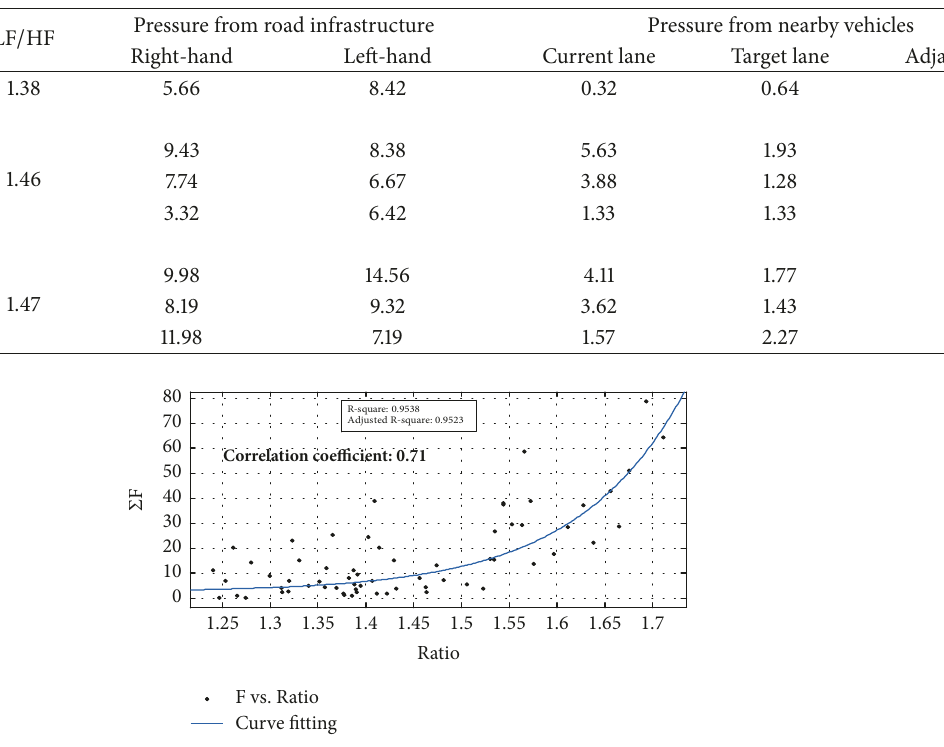
Table 4: Statistical results of average pressure and LF/HF.